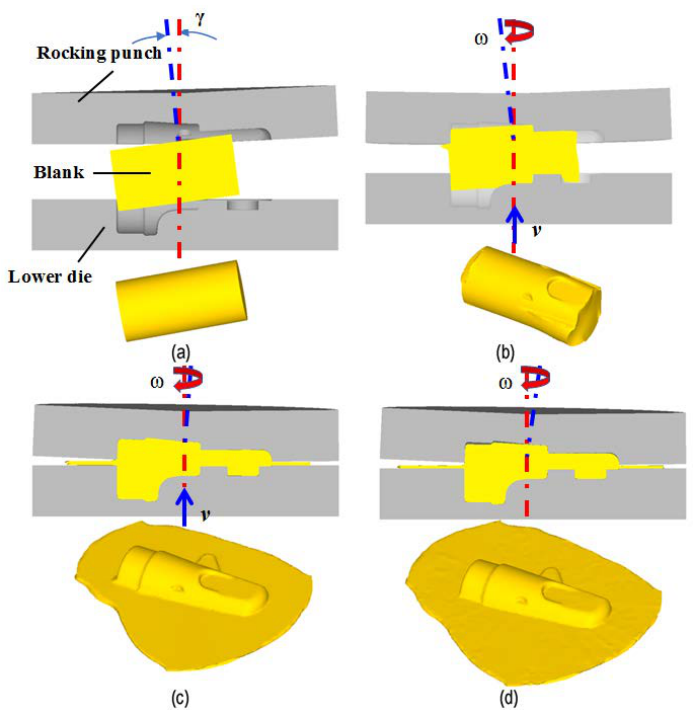
Figure 3. Schematic diagram of one-step cold orbital forming aluminum alloy base: ( a ) initial stage; ( b ) forming stage; ( c ) finished stage; ( d ) shaping stage.